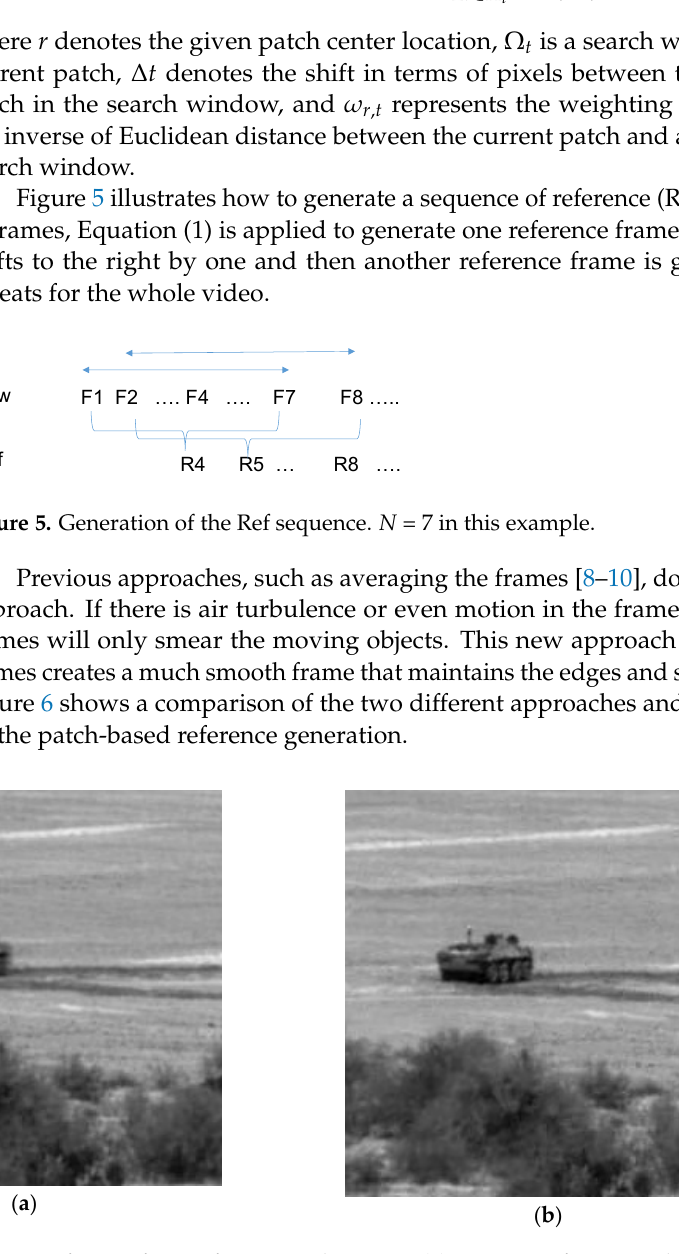
Figure 6. Comparison of generating reference frames for image alignment. ( a ) Averaging frame results; ( b ) Result using the approach in [13].